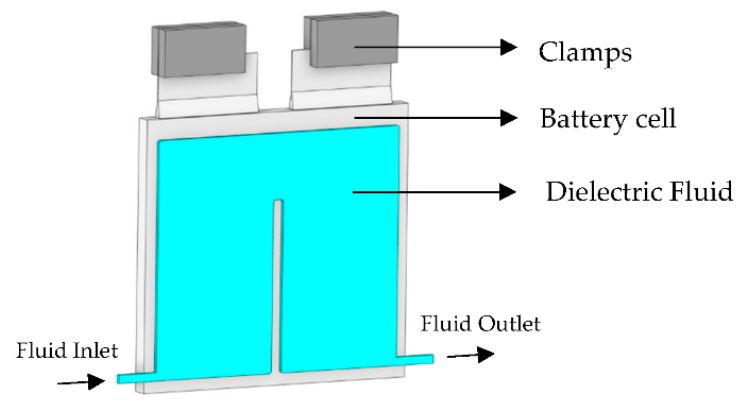
Figure 2. Principal components defined in the simulation model.